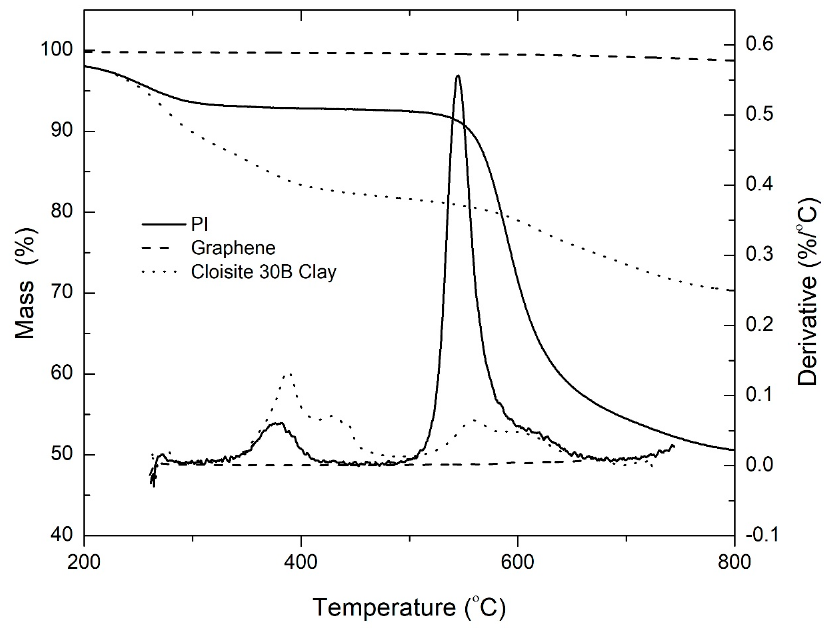
Figure 2. TGA thermograms for neat polyimide, graphene, and Cloisite 30B clay in nitrogen atmosphere at a heating rate of 30 °C/min.